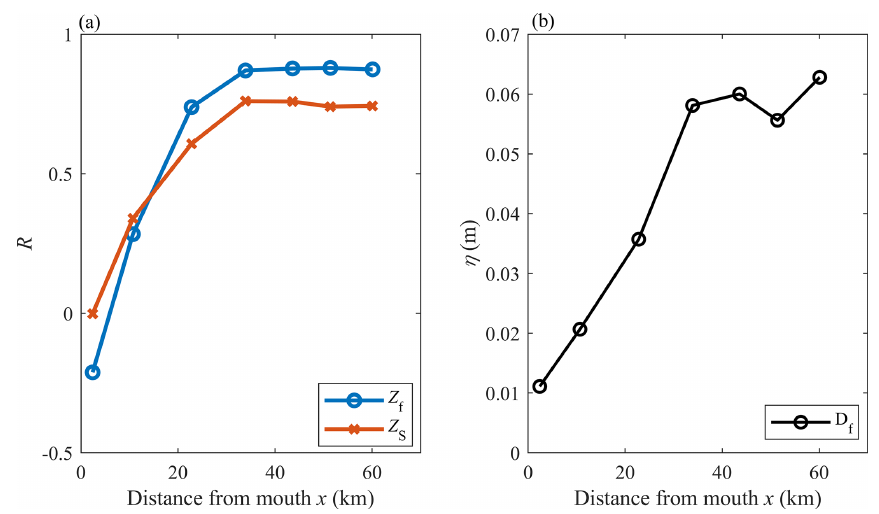
Figure 3. (a) Correlation coefficient ( R ) of the tidal amplitude forcing with the fortnightly water level Z f (blue line) and subtidal water level Z s (red line) along the estuary. (b) Amplitude of the 15d tidal species D f along the estuary during the neap–spring tidal cycle of 24–31 August 2015.